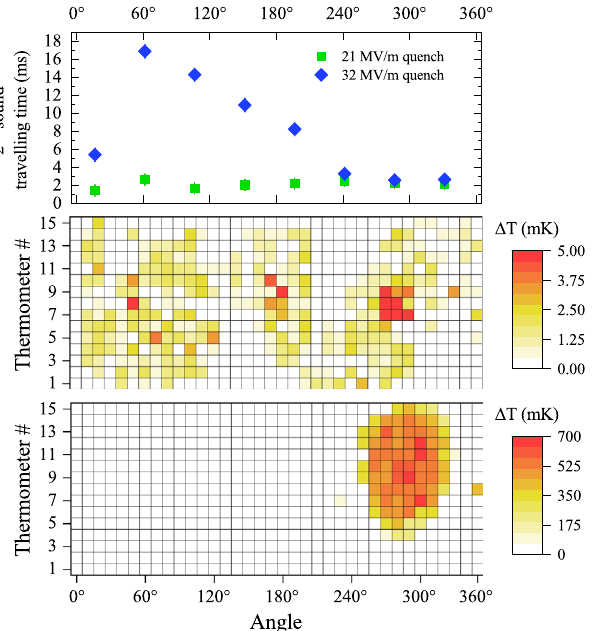
FIG. 8. Second sound (top) and temperature map data for the 1.3 GHz single cell cavity. The middle plot shows heating in steady state at 21 MV = m after a sporadic quench, and the bottom plot shows heating immediately following a quench at 32 MV =